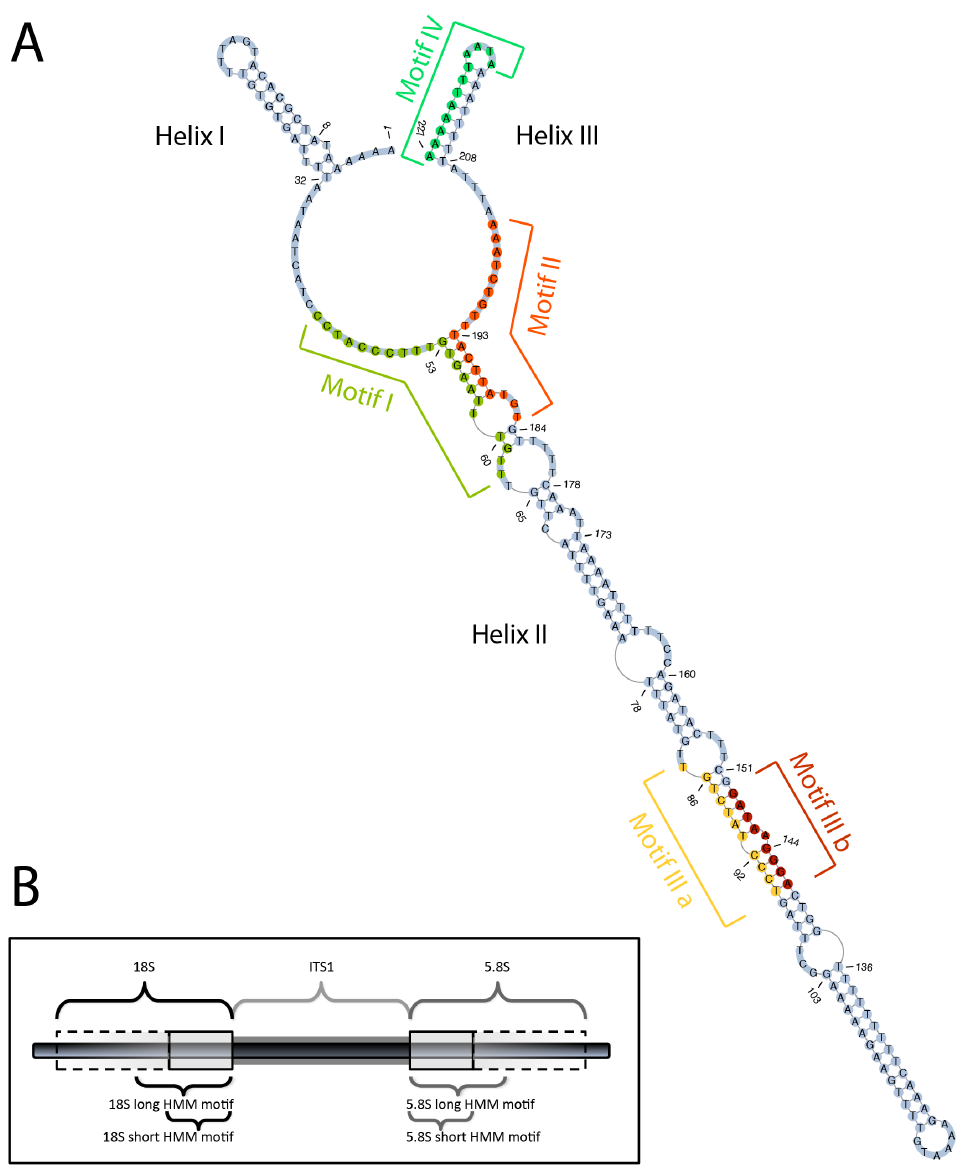
Figure 1. Visualization of secondary structure, sequence motifs and sequence annotation. ( A ) The secondary structure of the ITS1 region of JF423742 (selected as an example) illustrates the common core shape observed in all analysed neocallimastigomycete sequences. It folds into a three helix conformation, with two short helices (I and III) and a longer one in between (II). Additionally, four very conserved sequence motifs are highlighted in the structure. ( B ) The black bar shows a nucleotide string of rDNA. On the left is the terminus of the 18S rRNA gene, with its 18S HMM. Together with the 5.8S HMM motif on the right, both enable an exact delineation of the ITS1 region.